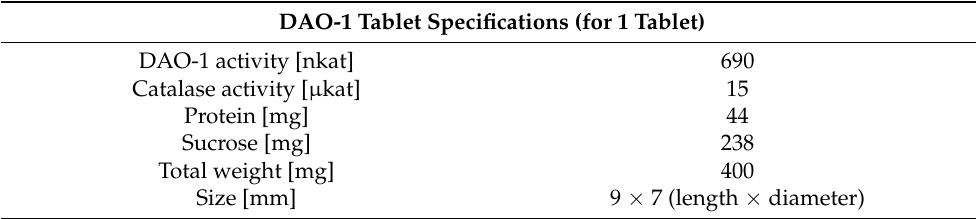
Table 1. Specifications of the DAO-1 tablet.